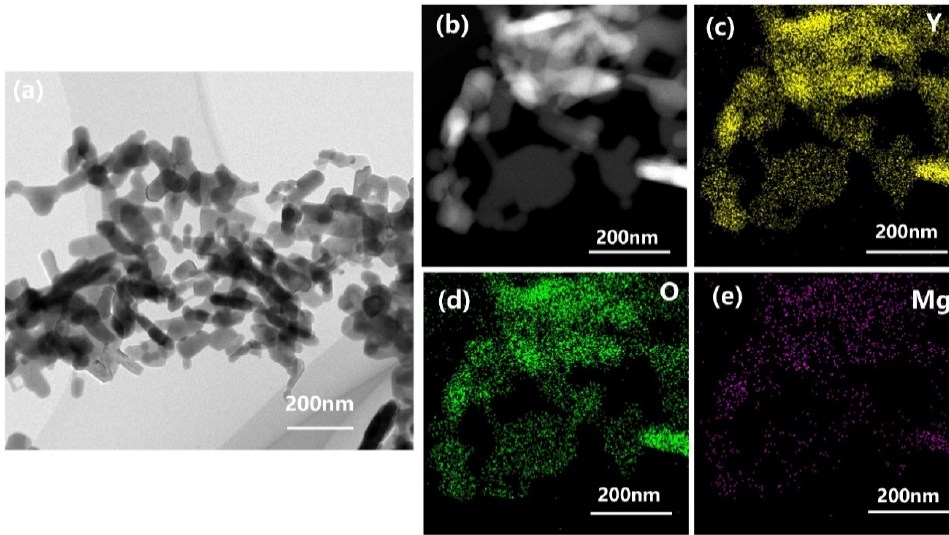
Figure 7. ( a ) TEM micrograph of hydrothermal MgO-Y 2 O 3 powders at 190 °C with 5% seeds; ( b ) bright-field TEM image and EDS micrographs of ( c ) Y, ( d ) O and ( e ) Mg of hydrothermal MgO- Y 2 O 3 powders at 190 °C with 5% seeds. The Y(NO 3 ) 3 ·6H 2 O and Mg(NO 3 ) 2 ·6H 2 O with a Y 2 O 3 -to-MgO volume ratio (Y 2 O 3 :MgO